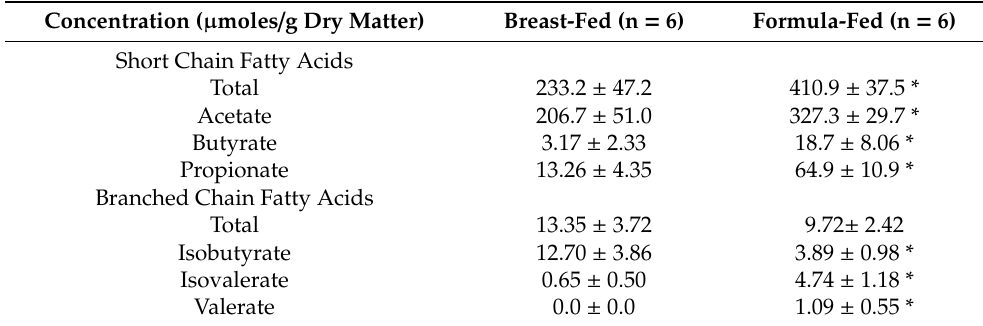
Table 1. Volatile fatty acid concentrations in stool of breast- and formula-fed infants. Data are presented as mean ± standard error of the mean